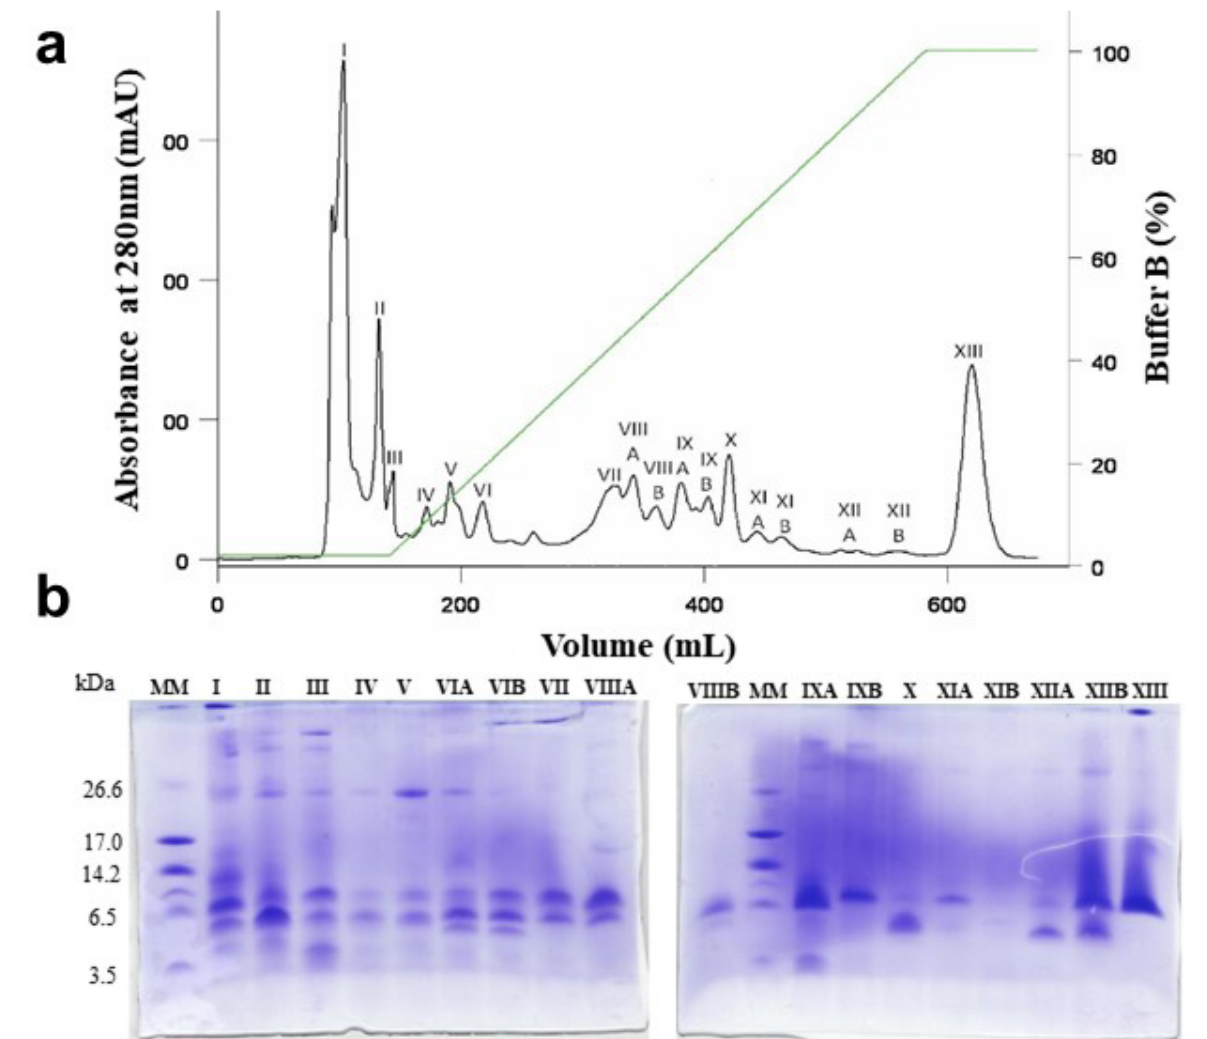
Figure 1. A: Chromatographic profile of Tityus serrulatus venom in FPLC system with CMC-52 column. Fractionation of Ts venom (50 mg) was performed in a FPLC system with CMC-52 column, equilibrated with buffer A (50 mM ammonium bicarbonate, pH 7.8), under a flow rate of 0.5 mL/min and 25 °C. Sample (2 mL) was initially eluted with buffer A, followed by a linear concentration gradient (0 to 100%) of buffer B (0.6 M ammonium bicarbonate, pH 7.8), represented by the green line. Volume collected per tube: 4.0 mL. B: Electrophoretic profile of the fractions from the CMC-52 chromatography in 16.5% Tricine-SDS-PAGE. Gel was stained with PlusOne Coomassie Blue PhastGel ® R-350 and destained with 10% acetic acid